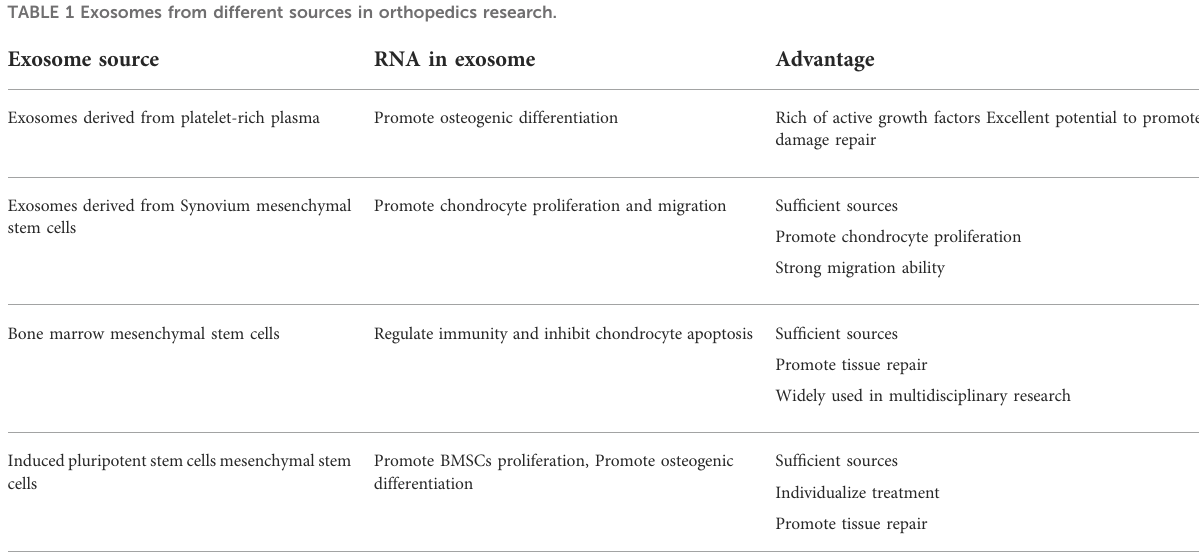
TABLE 1 Exosomes from different sources in orthopedics